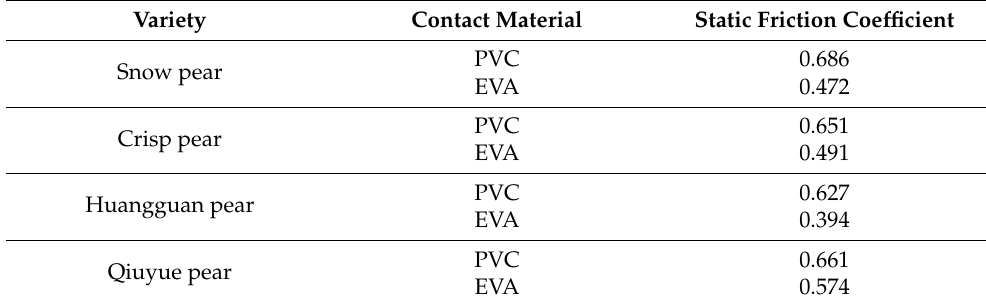
Table 8. Measured values of rolling friction coefficient between typical pears and materials.